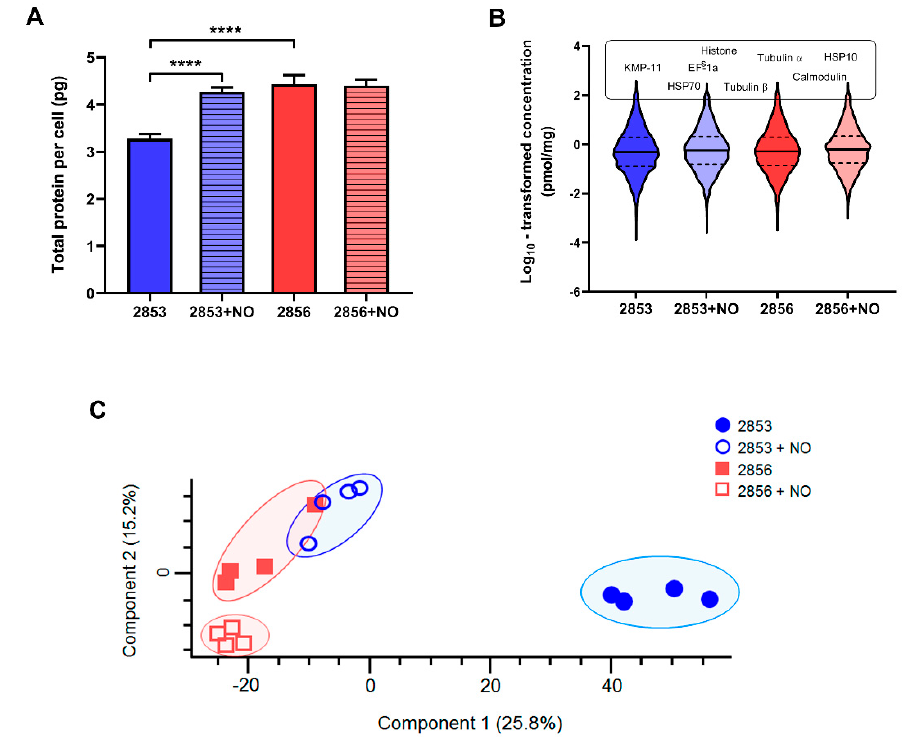
Figure 3. NO-resistance modulates protein abundance of L. braziliensis strains. Whole cell lysates from 2853, 2853+NO (2853 challenged with the 1 / 5 IC 50 /4 h NaNO 2 ), 2856, and 2856+NO (2856 challenged with the 1 / 5 IC 50 /4 h NaNO 2 ) strains were processed by MED-FASP and analyzed by LC-MS/MS. Protein abundances were calculated based on the raw spectral intensities. ( A ) Total protein content per cell of four biological replicates for each strain. Graphs represent mean ± SD of four independent experiments. Statistical differences by t test (**** p < 0.0001). ( B ) Violin plots depicting distribution of log10 transformed protein concentration values of proteins identified and quantified in each strain. Protein names above violin plots represent most abundant proteins common for all